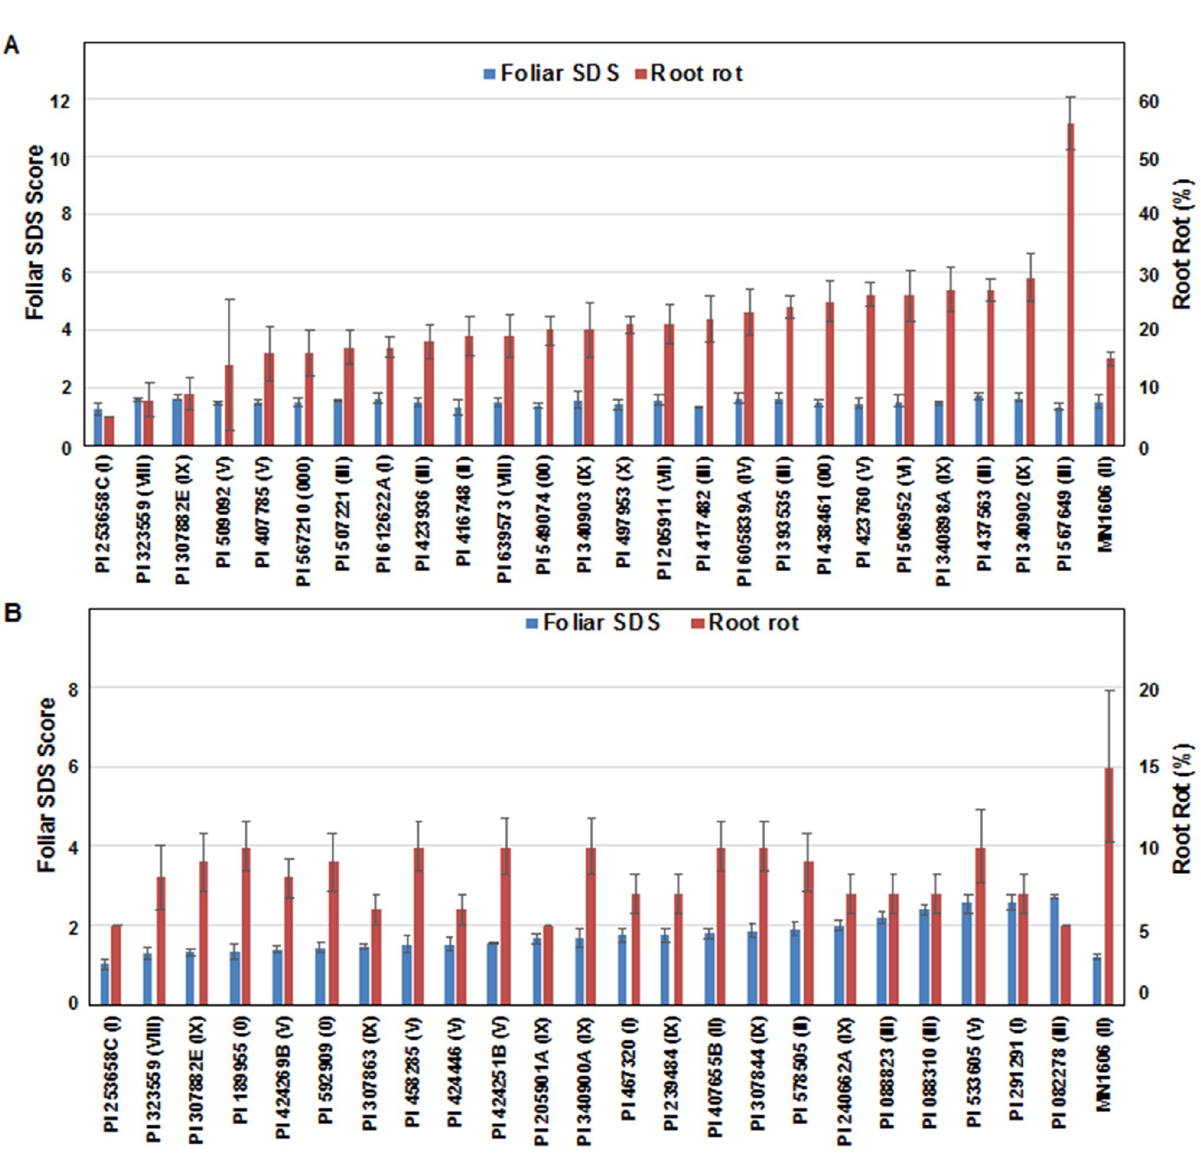
Fig 3. Segregation of foliar and root responses of 25 PI lines F . virguliforme . (A) Root responses of 25 most foliar SDS resistant PI lines to F . virguliforme . (B) Foliar responses of 25 most root rot resistant PI lines to F . virguliforme . The values are means and standard errors calculated from five independent experiments. The Scott-Knott statistical significance difference of the PI lines are provided in S1 Table.